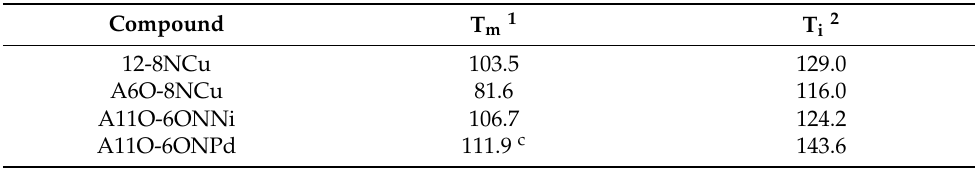
Table 1. Transition temperatures of MOMs.